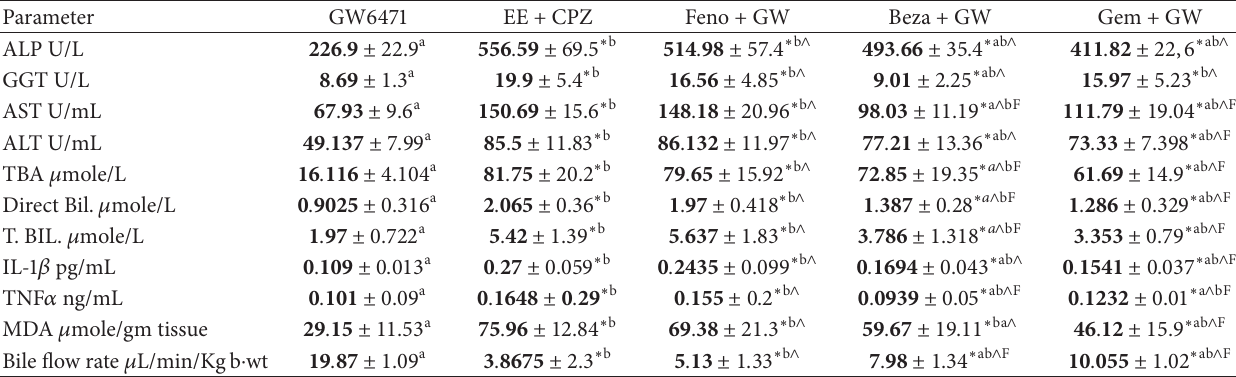
Table 2: Effect of pretreatment of EE and CPZ treated rats with PPAR 𝛼 receptor antagonist (GW6471) 1mg/kg/d i.p 30min before fenofibrate, bezafibrate, or gemfibrozil on biochemical parameters and bile flow rate.